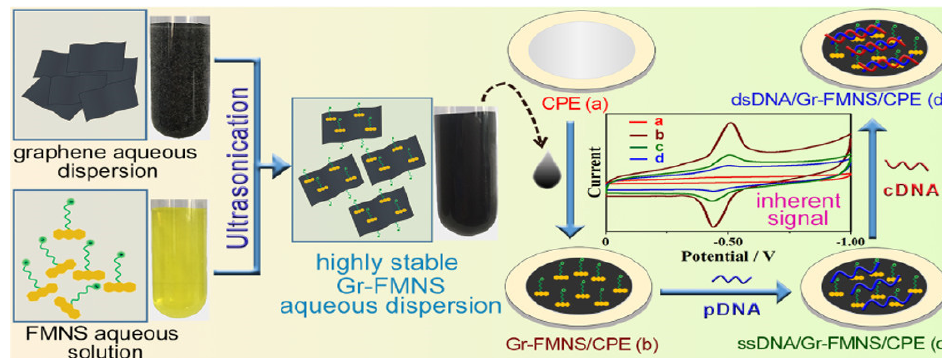
Figure 11. Fabrication of Gr-FMNS composite, methodology of modified electrode (carbon paste) preparation and electrochemical detection of Vibrio pathogen. Adapted with permission from Yang et al. [92]. Copyright © (2018), ACS.